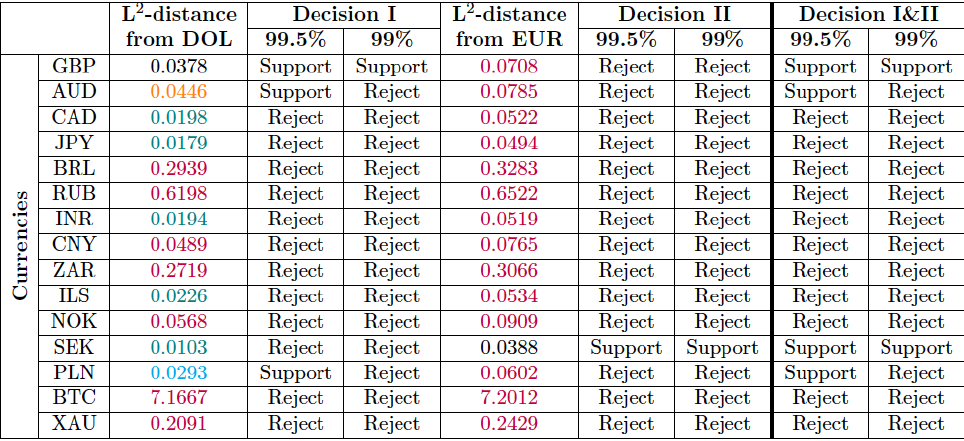
Figure 8. Results of the statistical tests.